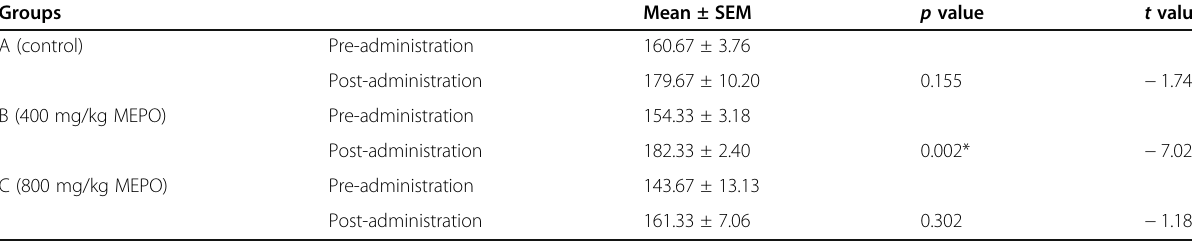
Table 1 The effect of MEPO on the bodyweight of adult female Wistar rats